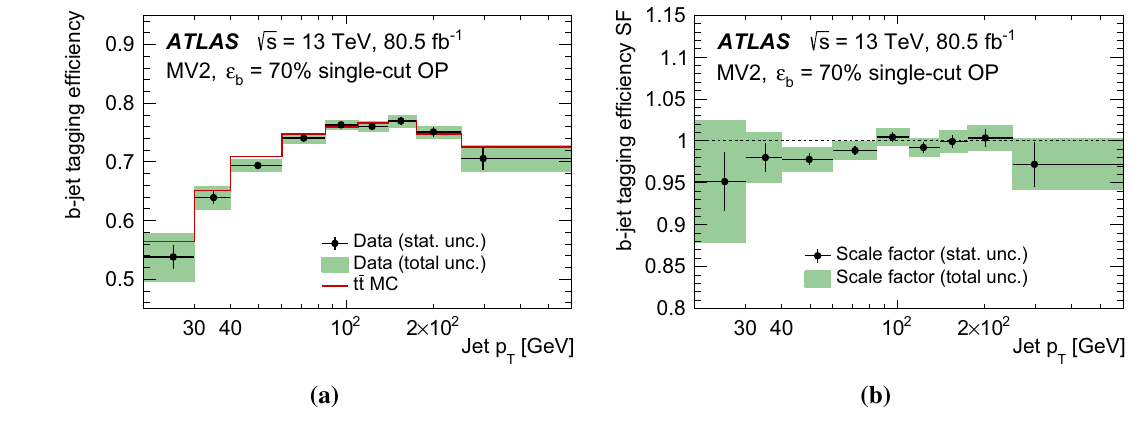
Fig. 8 The (a) b -jet tagging efficiency and (b) b -jet tagging efficiency simulation-to-data scale factors for the ε b = 70% single-cut OP of the MV2 tagger as a function of jet p T . The efficiency measurement is shown together with the efficiency derived from t ¯ t simulated events